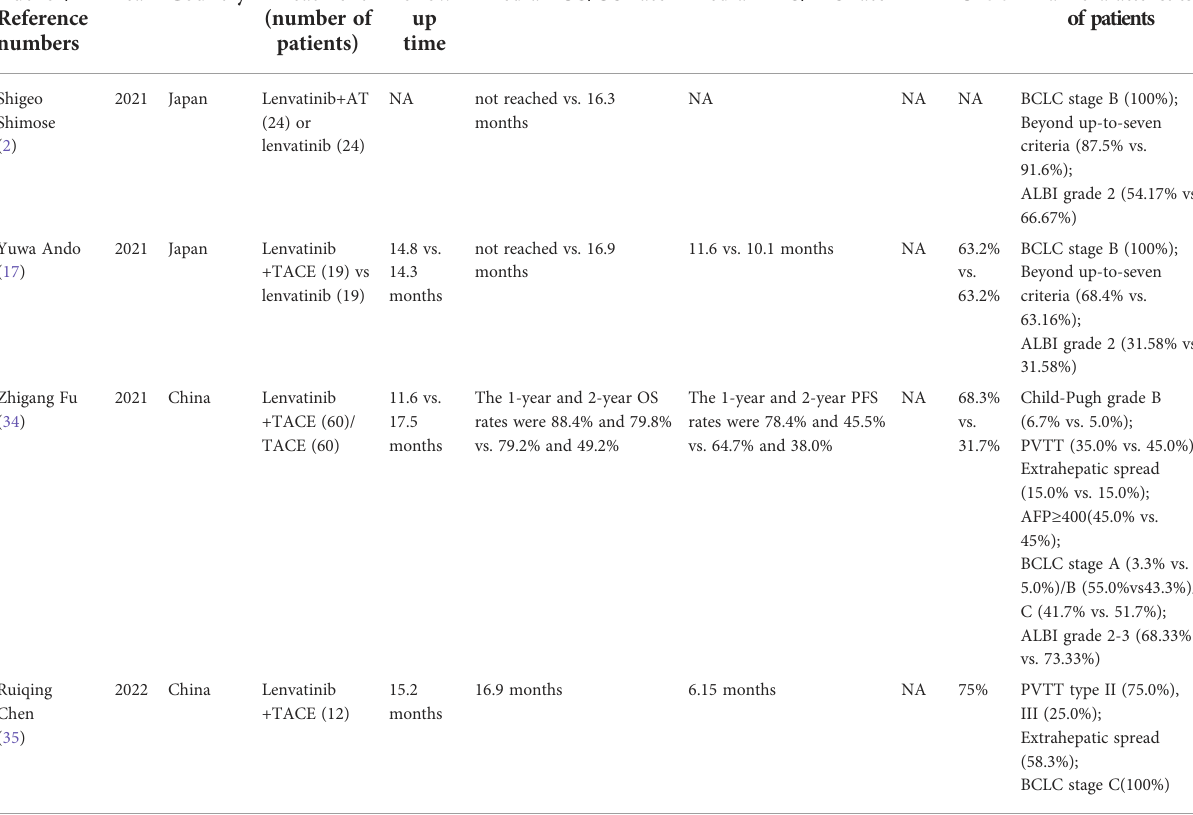
TABLE 1 Lenvatinib plus TACE therapy compared with lenvatinib or TACE